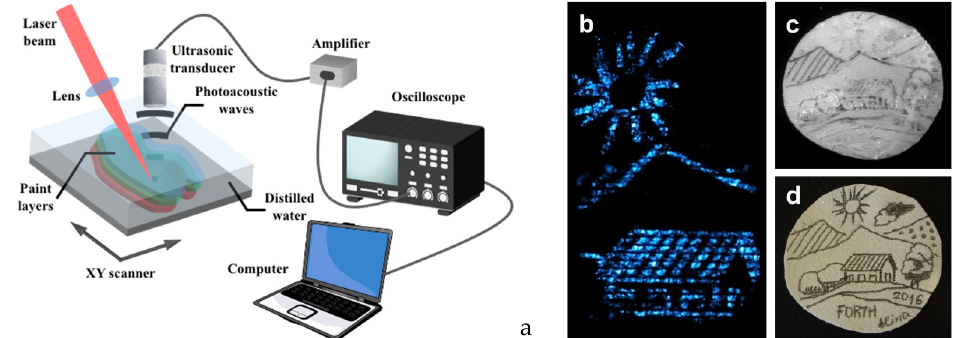
Figure 1. ( a ) Exemplificative PA setup; ( b ) detail of PA imaging obtained from a hidden drawing (figure adapted from [8]); ( c ) IR image in the hidden drawing; ( d ) original drawing.